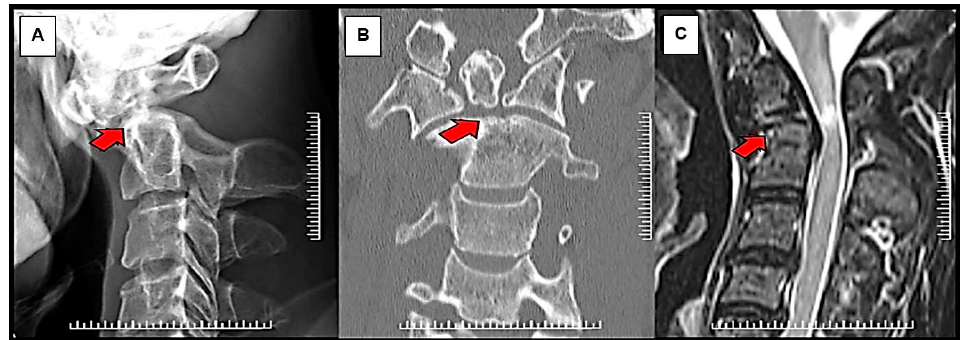
Figure 1. Radiographic images of nonunited type II odontoid fracture with atlantoaxial instability. Atlantoaxial instability with cervical myelopathy caused by nonunited type II odontoid fracture (Red arrows): ( A ) lateral plain radiograph; ( B ) coronal CT image; ( C ) sagittal MR image.